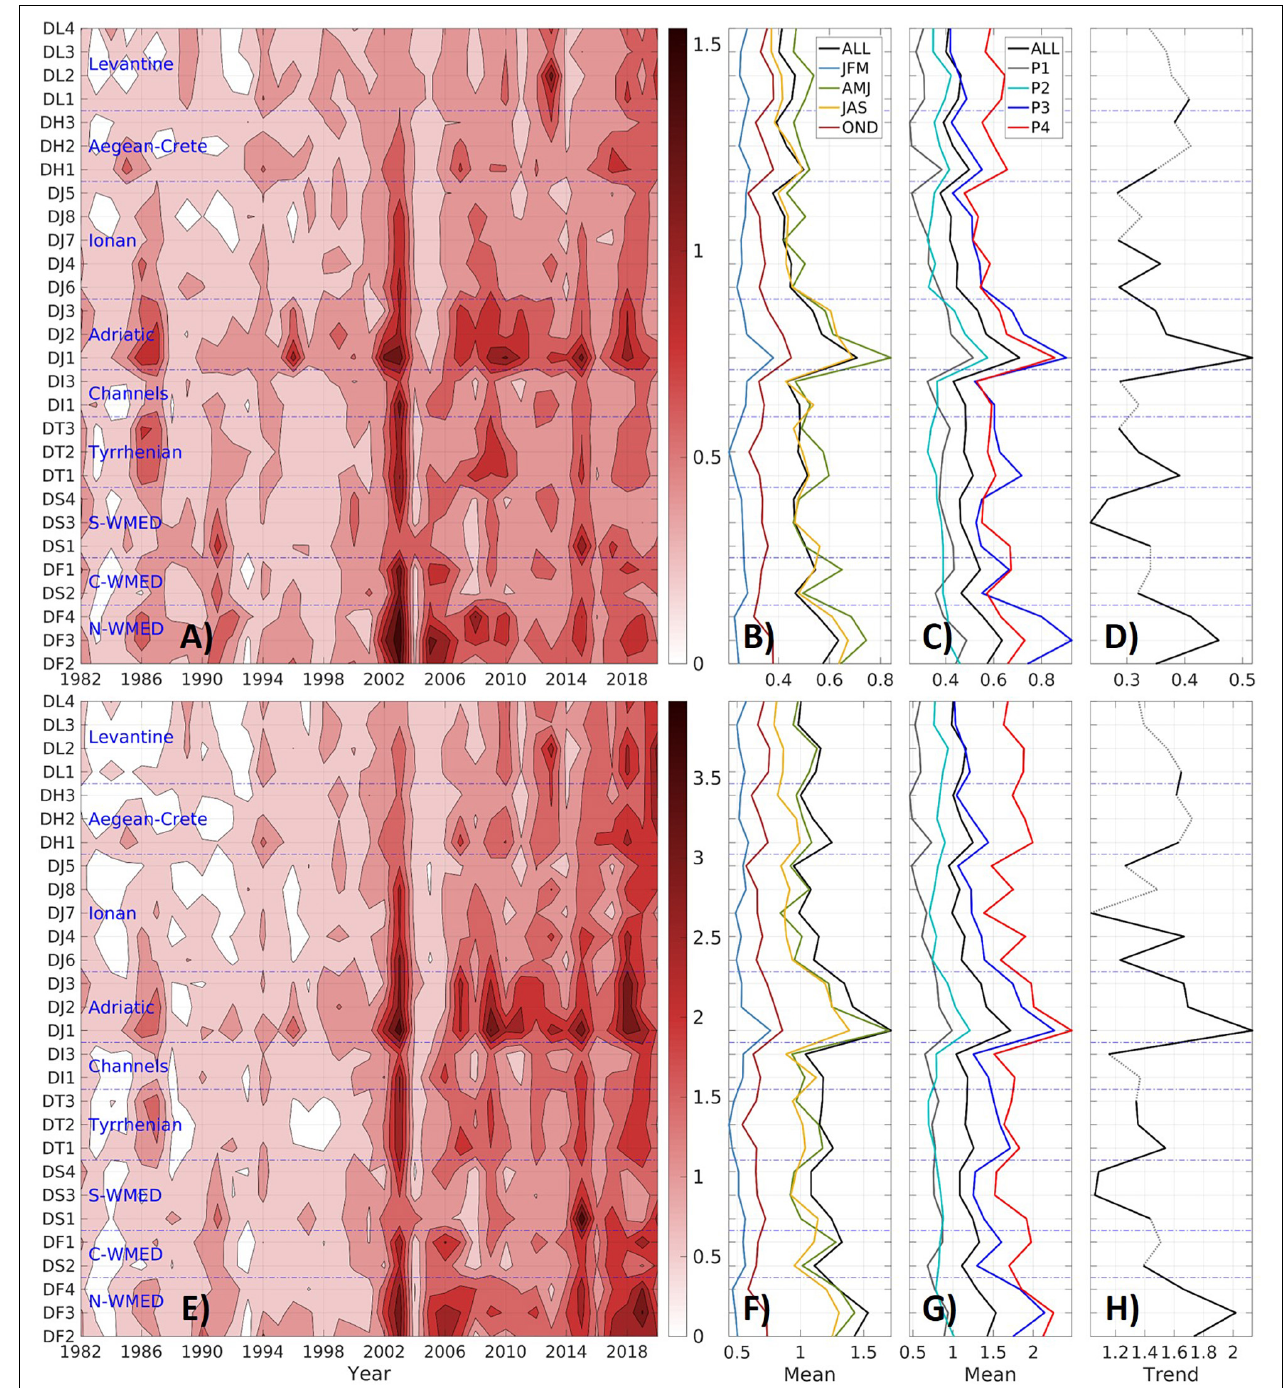
FIGURE 7 | Mean intensity (A–D) and maximum intensity (E–H) (in ◦ C): sub-regional annual means from 1982 to 2020 (A,E) , seasonal means (B,F) over 1982–2020 (ALL: all seasons; JFM: winter; AMJ: spring; JAS: summer; OND: autumn), period-averages over 1982–1991 [P1], 1992–2001 [P2], 2002–2011 [P3], 2012–2020 [P4] and 1982–2020 [ALL] (C,G) and linear trends over 1982–2020 (D,H) with 95% confidence (black solid line).